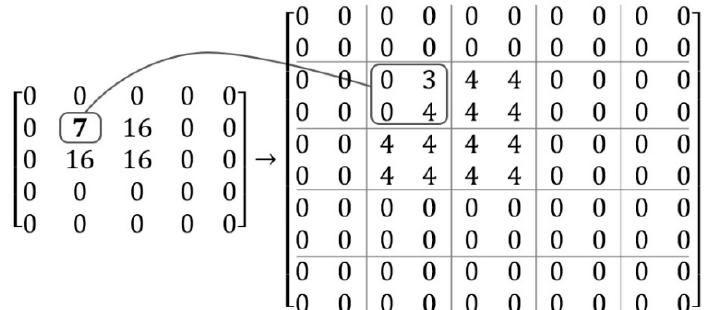
Figure 5. Transformation of the 5 by 5 array into a 10 by 10 array. In this example position of number 7 in the left array dictates the position of a list of numbers [0, 0, 3, 4] in the right array. The position of number 4 is conditioned by the surrounding cells to be next to the highest surrounding cell.